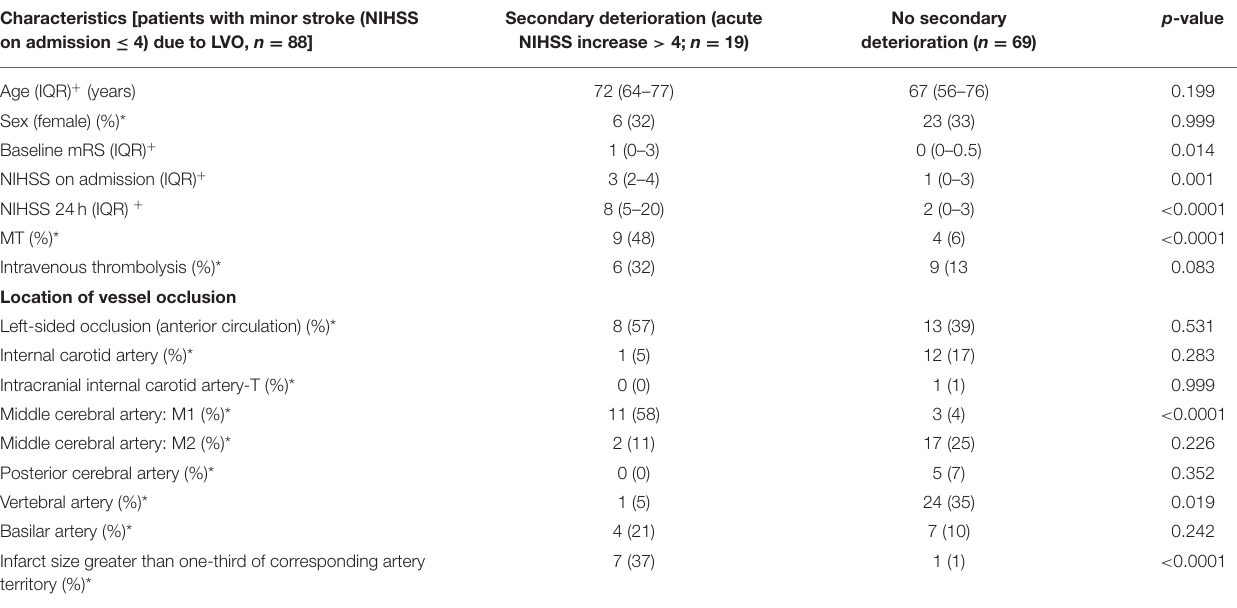
TABLE 3 | Characteristics of patients with minor stroke (NIHSS on admission ≤ 4) due to LVO stratified for secondary deterioration (acute NIHSS increase > 4 points during in-hospital stay). Characteristics [patients with minor stroke (NIHSS on admission ≤ 4) due to LVO, n =